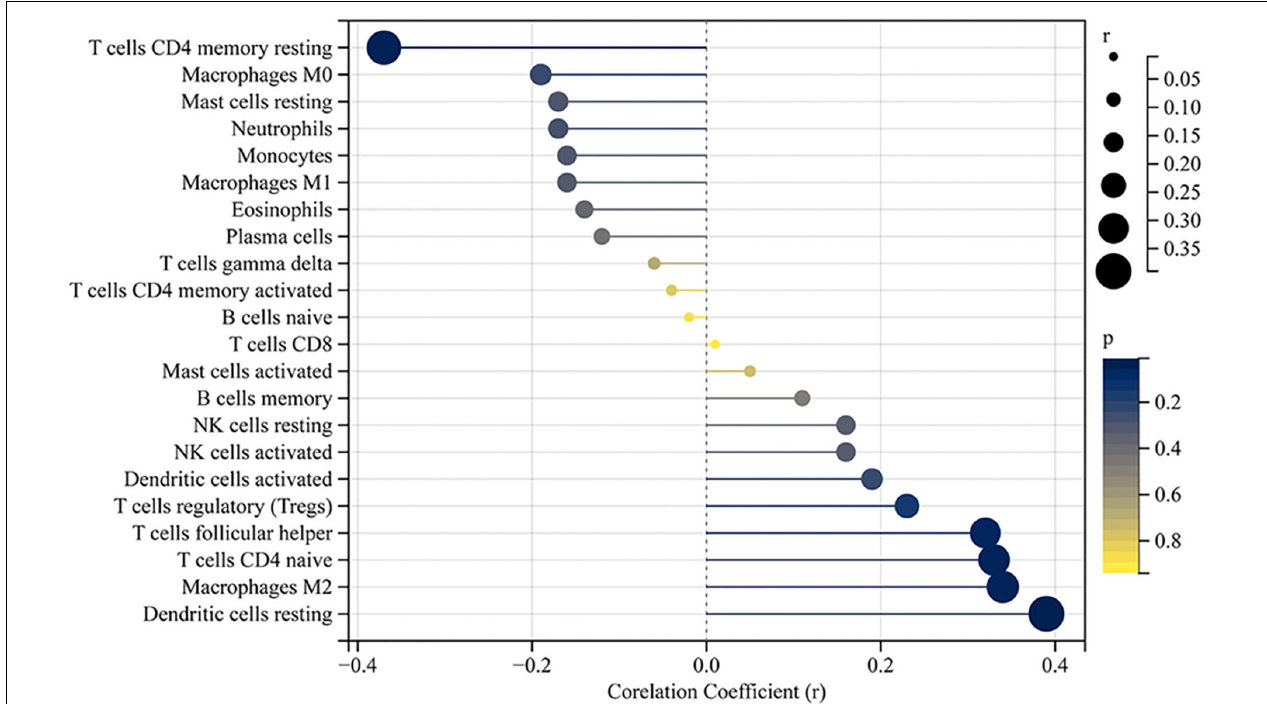
FIGURE 5 | Correlation between LECT2 and infiltrating immune cells. The size of the dots represents the strength of the correlation between LECT2 and immune cells; the larger the dots, the stronger the correlation, and the smaller the dots, the weaker the correlation. The color of the dots represents the p -value; the bluer the color, the lower the p -value, and the yellower the color, the larger the p -value. The p -value < 0.05 was considered statistically significant.